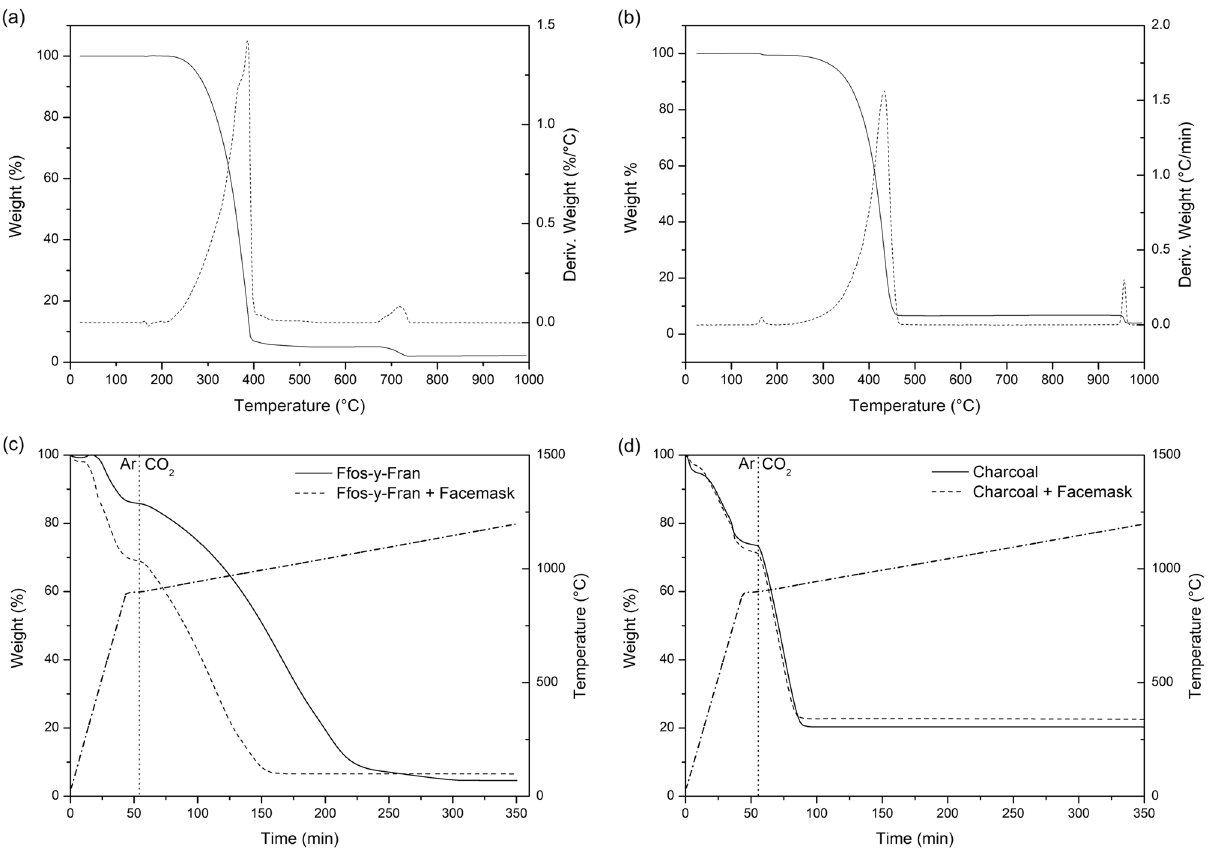
Figure 3. TGA-DTG curve for ( a ) untreated facemasks under a 100 cm 3 min −1 flow air, ( b ) untreated facemasks under a 100 cm 3 min −1 flow carbon dioxide. DTG signals are denoted as dashed lines. TGA measurements to 900 °C under Ar and to 1200 °C under CO 2 atmospheres for ( c ) GCI coal (solid line) compared to GCI coal/20 wt.% facemask blend (dashed line) and ( d ) Charcoal (solid line) compared to charcoal/20 wt.% facemask blend (dashed